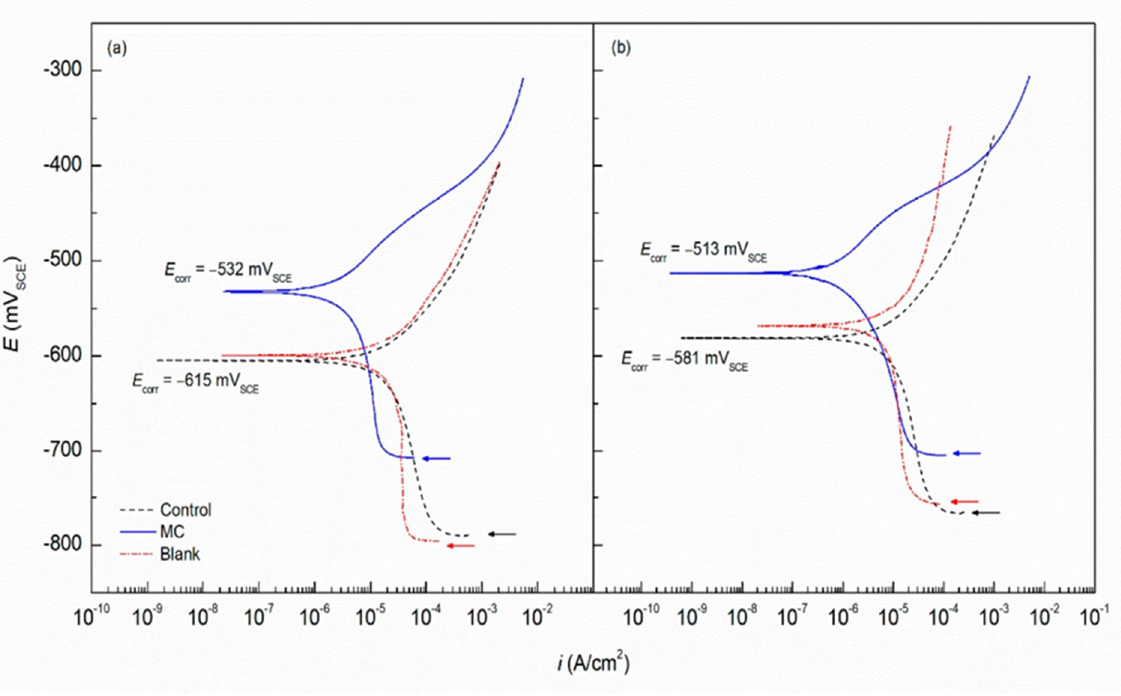
Figure 8. Potentiodynamic curves with acrylic coating doped with colophony microcapsules deposited on mild steel in ( a ) DI water (pH 6.8) and ( b ) SCPS (pH 12.6) [127].